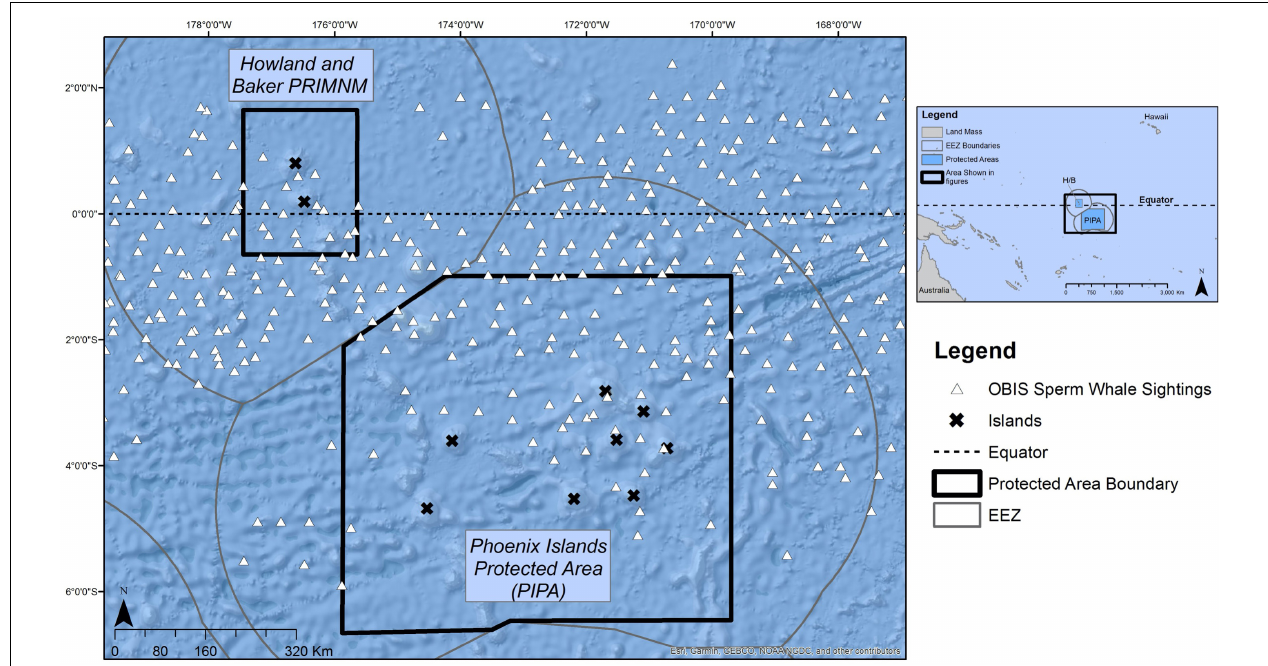
FIGURE 7 | OBIS records of sperm whale sightings in and around the Phoenix Islands and Howland and Baker units of the Pacific Remote Islands Marine National Monument (PRIMNM). All sightings in OBIS come from 1913, which were from the Wildlife Conservation Society Dataset (Woolmer,